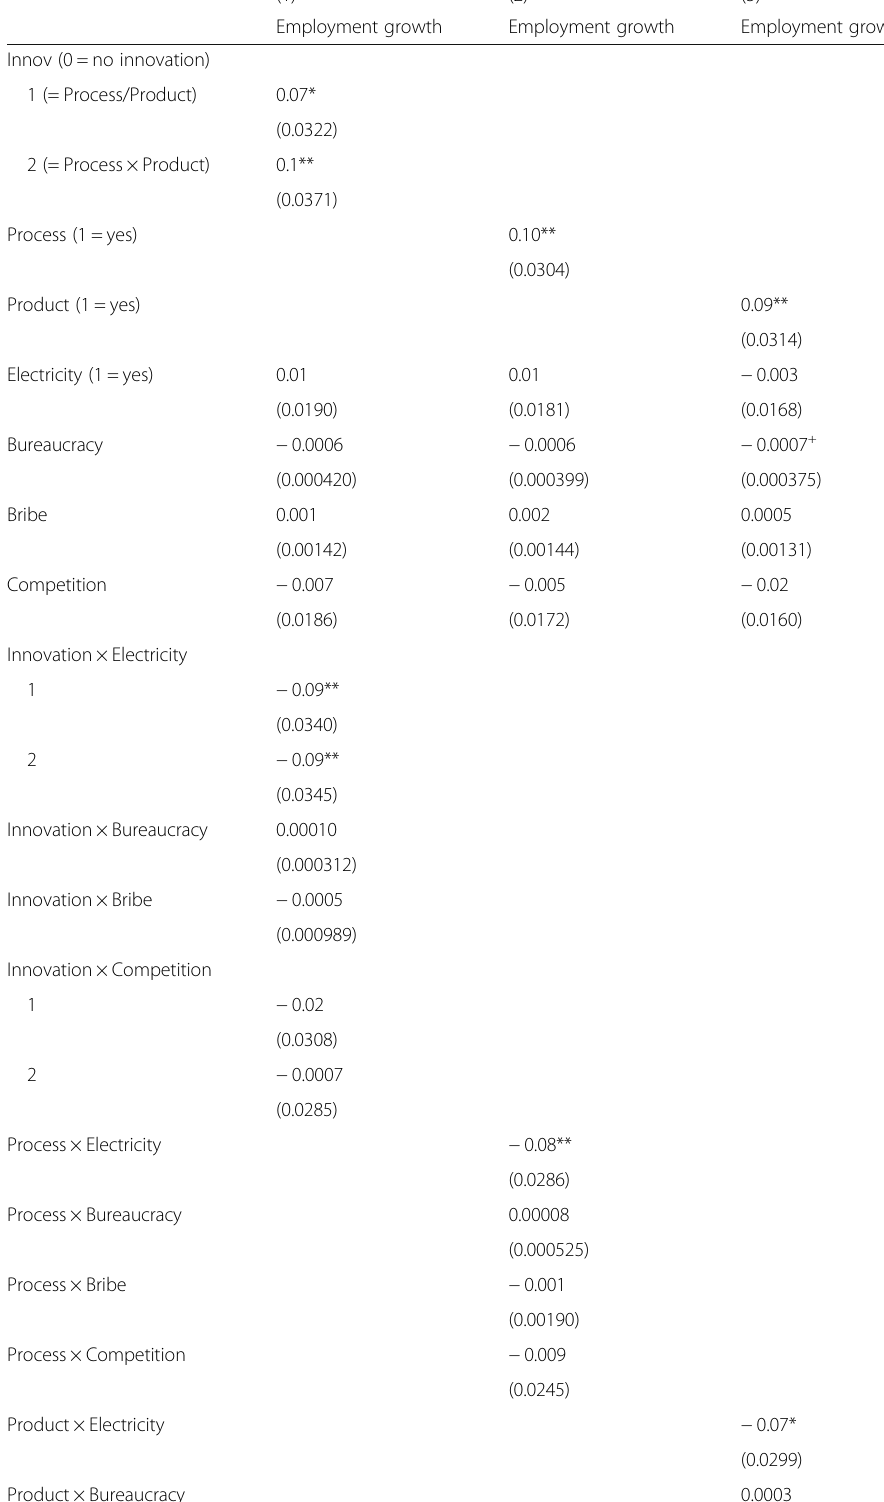
Table 7 Interaction between innovation and the business